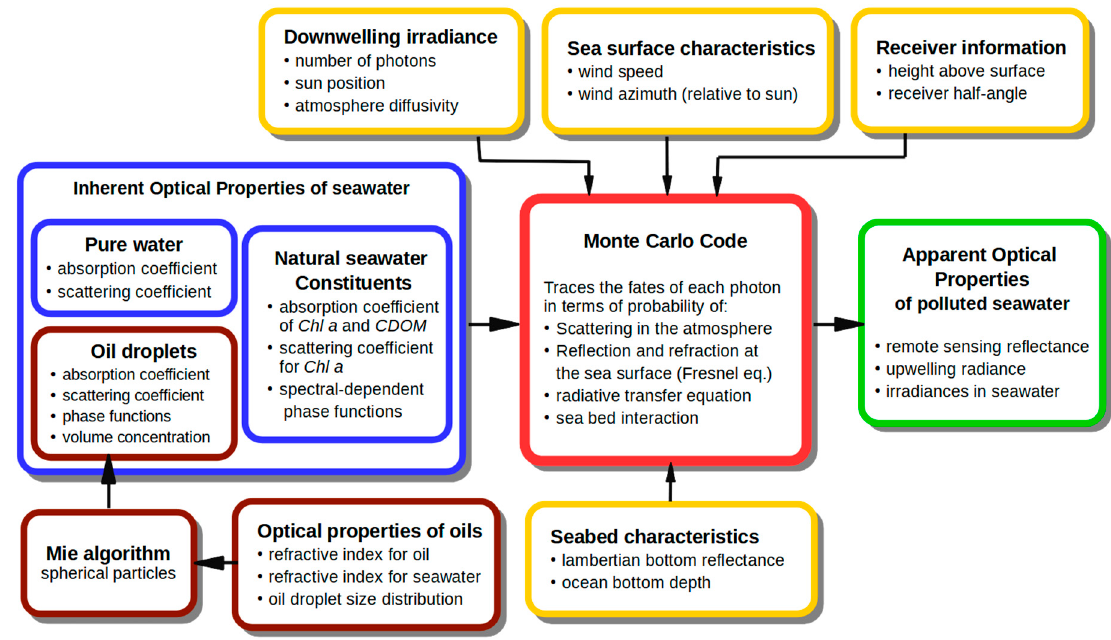
Figure 3. Scheme of the model of radiative transfer in seawater polluted by dispersed oil: yellow boxes mark the input boundary conditions, blue boxes illustrate the input optical properties of natural seawater; data related to dispersed oil droplets are in brown boxes, and model output data are in the green box.